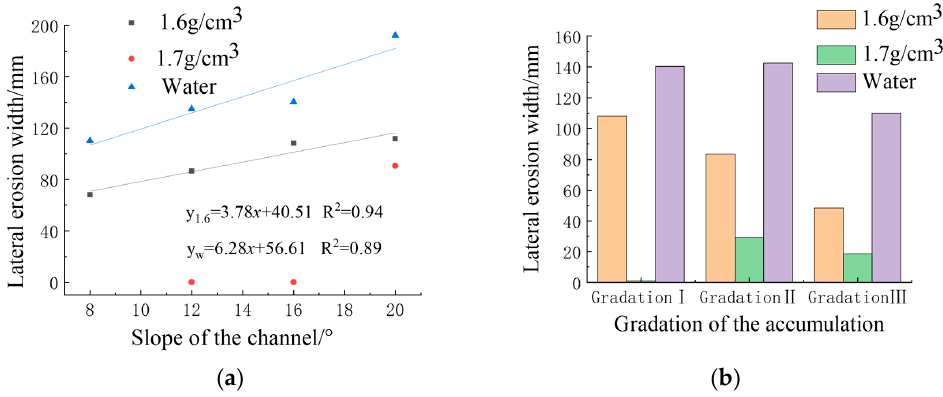
Figure 8. Lateral erosion width. ( a ) Erosion width under different slope gradients. ( b ) Erosion width under different graded accumulations.